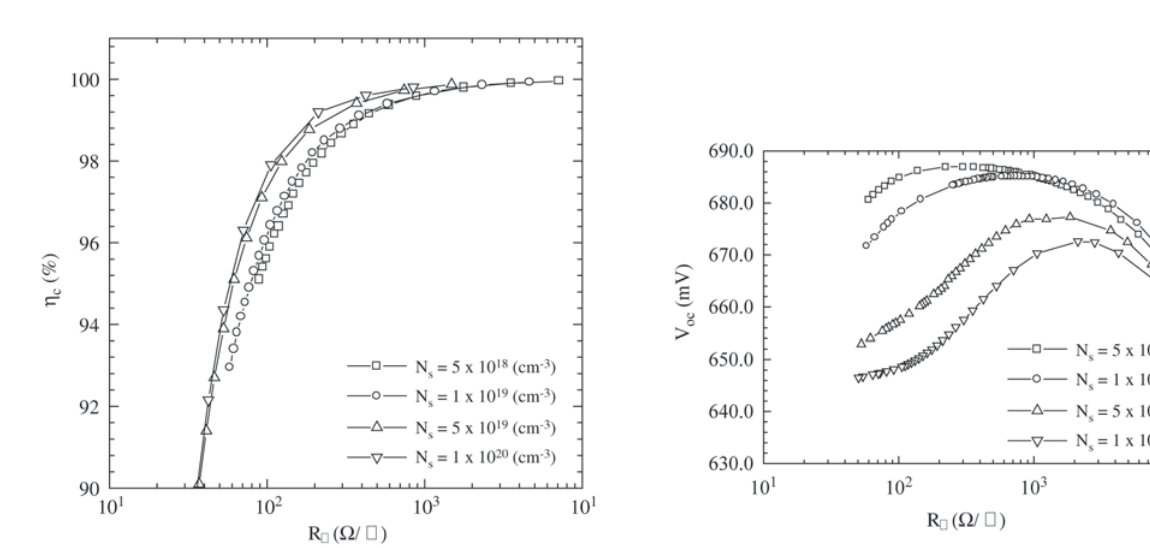
as function of emitter c , considering s